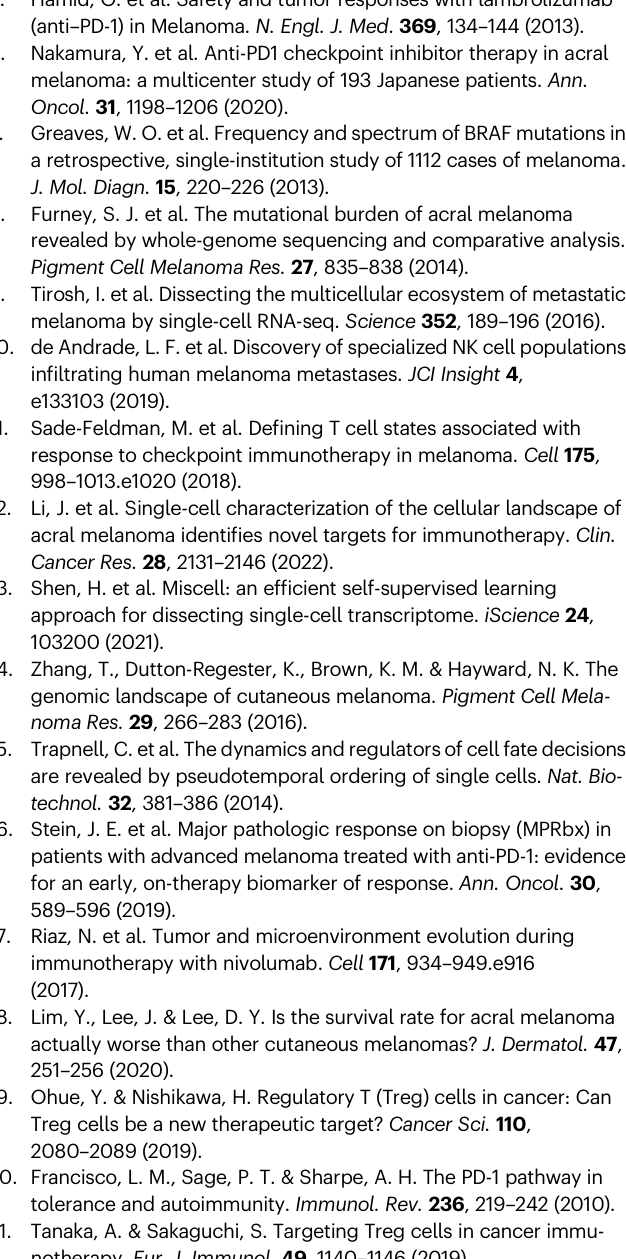
Fig. 6 | Differences in pre-treatment and post-treatment samples from an immune-resistant patient with acral melanoma. A Histogram showing the dif- ference in ratio of immune cells subtypes between the pre-treatment and post- treatment samples. Signi fi cance was calculated using the two-side, unpaired Fish- er ’ s exact test (*** P -value<0.05, B cell P -value=4.54e-09, CD4+ T cell P -value= 1.14e-14, CD8+ T P -value=1.36e-05, Cycle T cell P -value=1.36e-08, Monocyte and Macrophage P -value=0.351, NK cell P -value=0.380, Treg P -value=0.898).